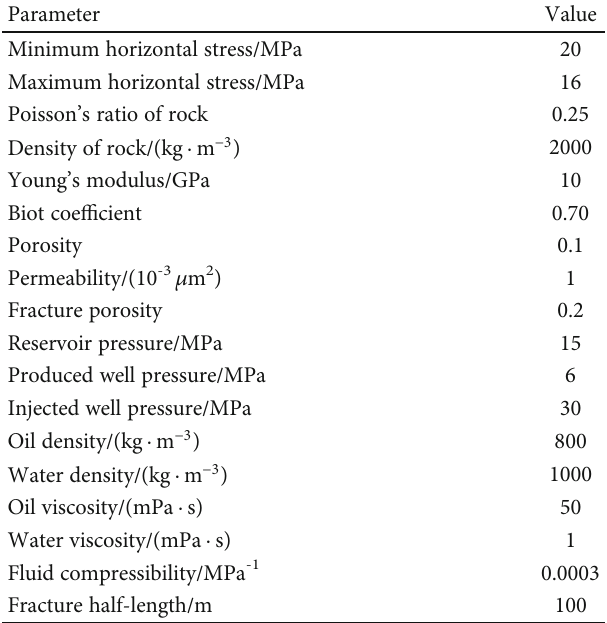
Table 2: Basic parameters used in numerical